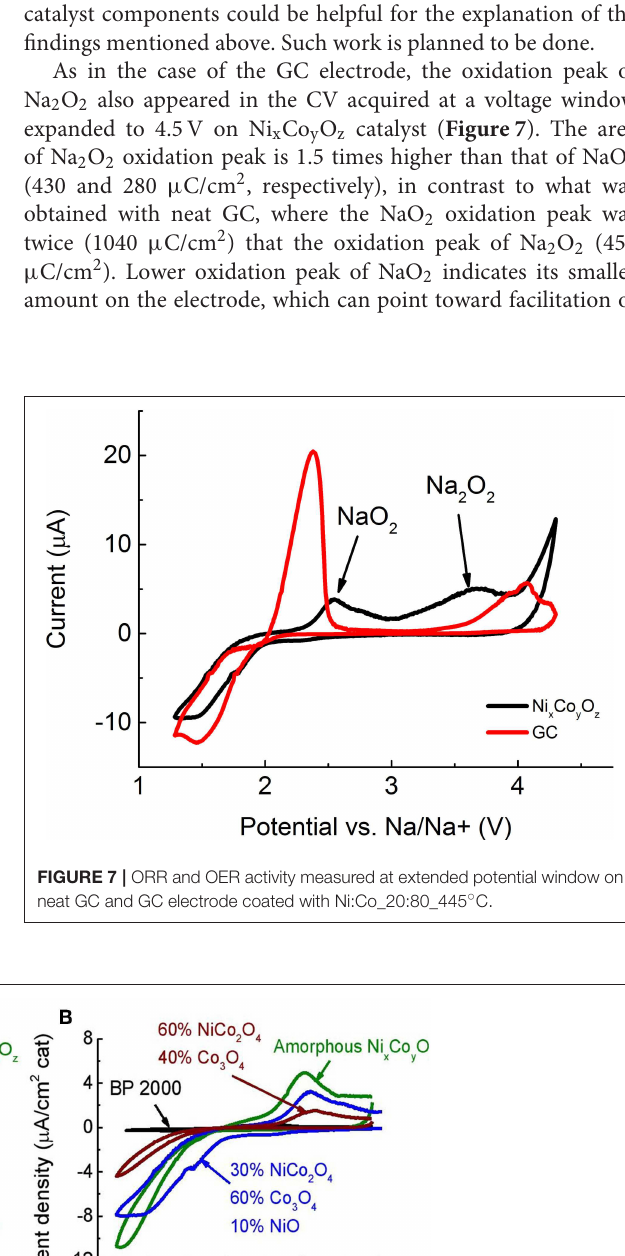
Frontiers in Materials |